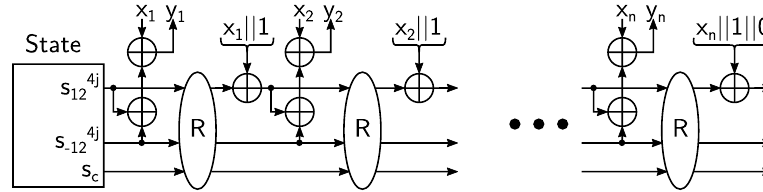
Figure 7: Subterranean absorb with operation encryption.